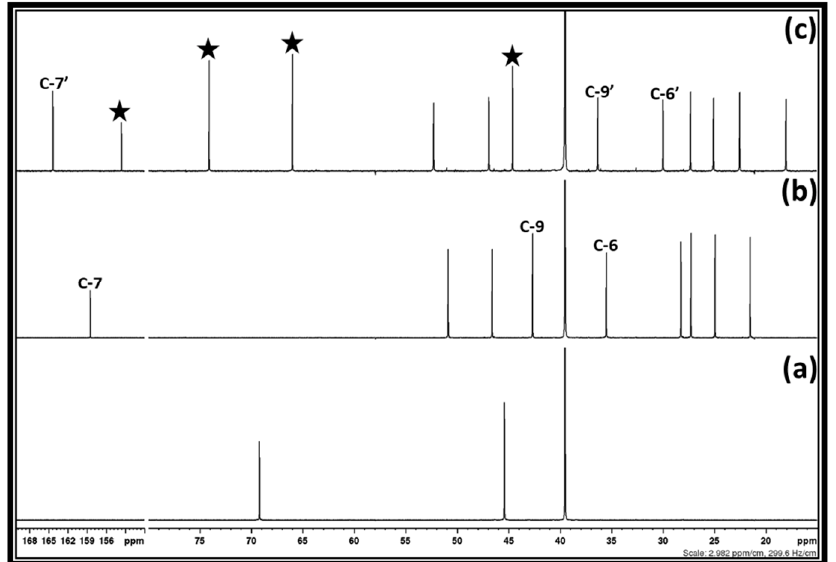
Figure 2. 13 C NMR spectra of the ( a ) 1,3-dichloro-2-propanol, ( b ) DBU, and ( c ) Reaction mixture after equivalent interaction of 1,3-dichloro-2-propanol, DBU, and CO 2 in DMSO (NMR analysis with capillary filled with D 2 O).